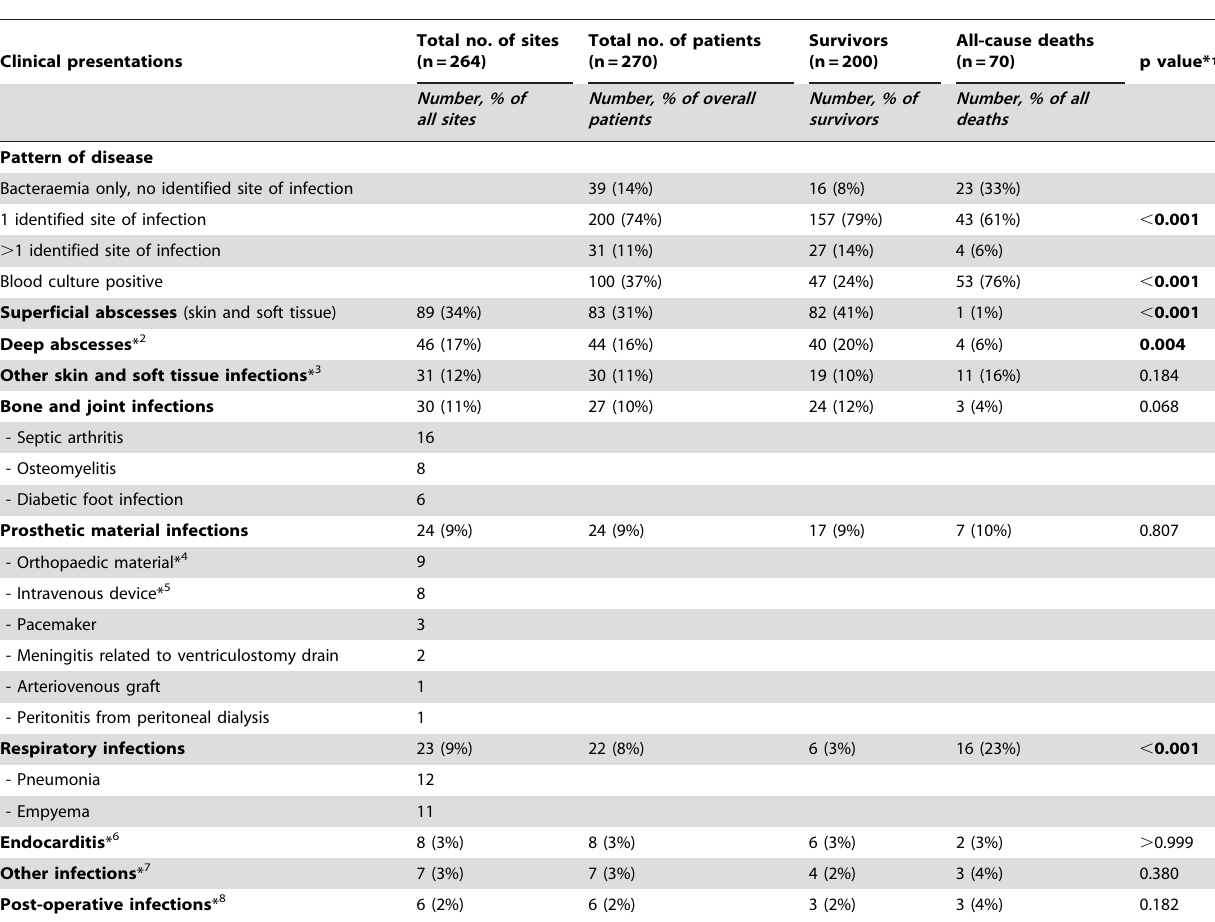
Table 2. The range of sites of infection in patients and outcome associated with each clinical presentation.